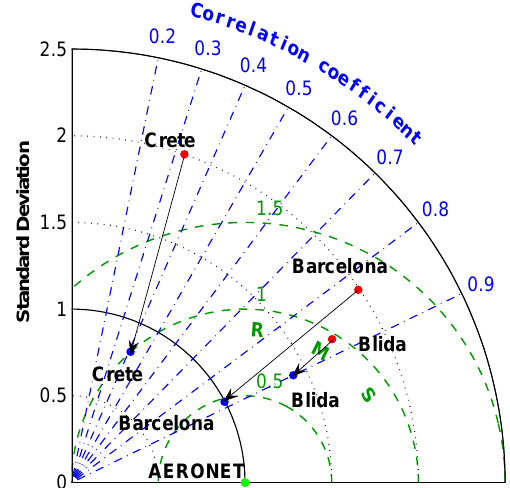
Fig. 8. Taylor diagram representing the correlation in time between observations (AERONET data presented in Fig. 7) and RegCM-4 simulations of the AOD. Red points: REF, blue points: NEW, green point: